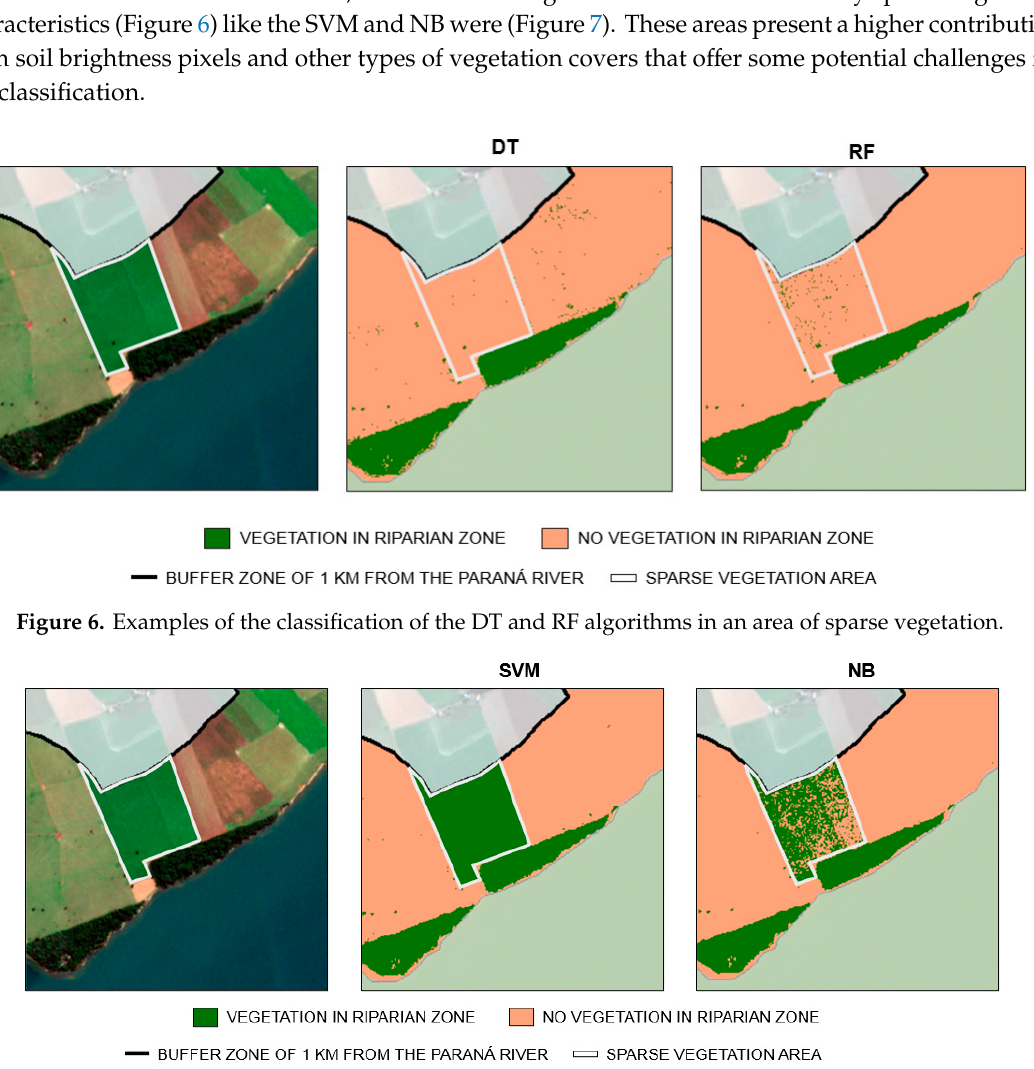
Figure 5. Results of the image classifications of each algorithm.